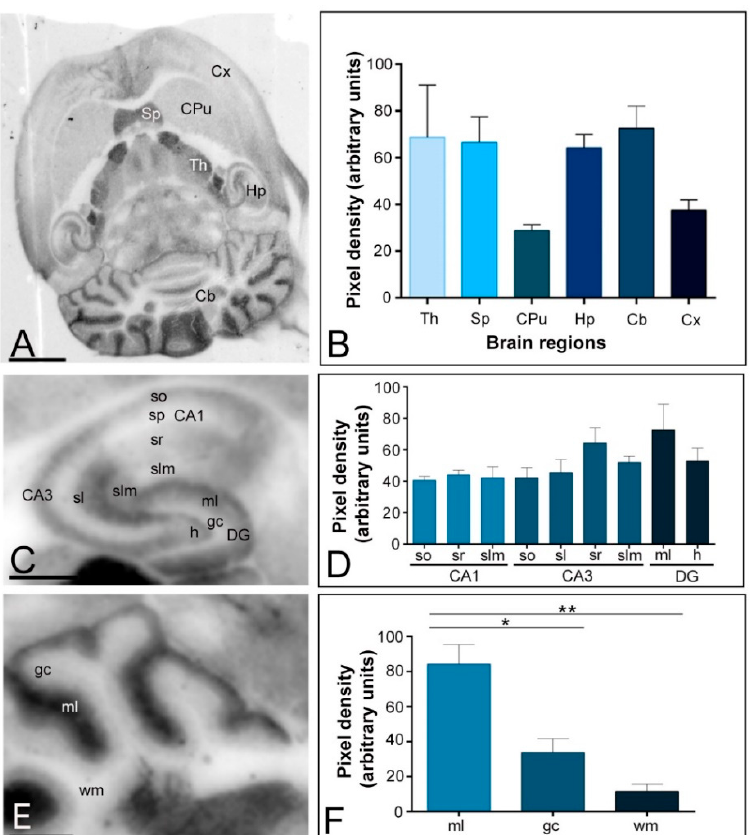
Figure 2. Regional distribution of the Kv4.3 channel in the adult mouse brain. ( A , B ) The distribution of the Kv4.3 protein was visualised in histoblots of horizontal brain sections at P60 using an affinity-purified anti-Kv4.3 antibody. Kv4.3 expression in different brain regions was determined by densitometric analysis of the scanned histoblots. The strongest expression was detected in the cerebellum (Cb), thalamus (Th) septum (Sp) and hippocampus (Hp), with weaker expression in the cortex (Cx) and caudate putamen (CPu); ( C , D ) In the hippocampus, strong Kv4.3 expression was detected in the stratum radiatum (sr) of the CA3 region and in the molecular layer (ml) of the dentate gyrus (DG), moderate labelling was observed in all dendritic layers of the CA1 region, the strata oriens (so) . Lucidum (sl) and lacunosum-moleculare (slm) of the CA3 region, as well as in the hilus (h) of the dentate gyrus. Very weak Kv4.3 staining was evident in the stratum pyramidale of the CA1 and CA3 regions and in the granule cell layer of the dentate gyrus; ( E , F ) In the cerebellum, the strongest expression level was detected in the molecular layer (ml), weak expression in the granule cell layer (gc) and very weak in the white matter (wm). Error bars indicate SEM; * p < 0.05; ** p < 0.01. Scale bars: A , 1 mm; C and E , 0.5 mm.